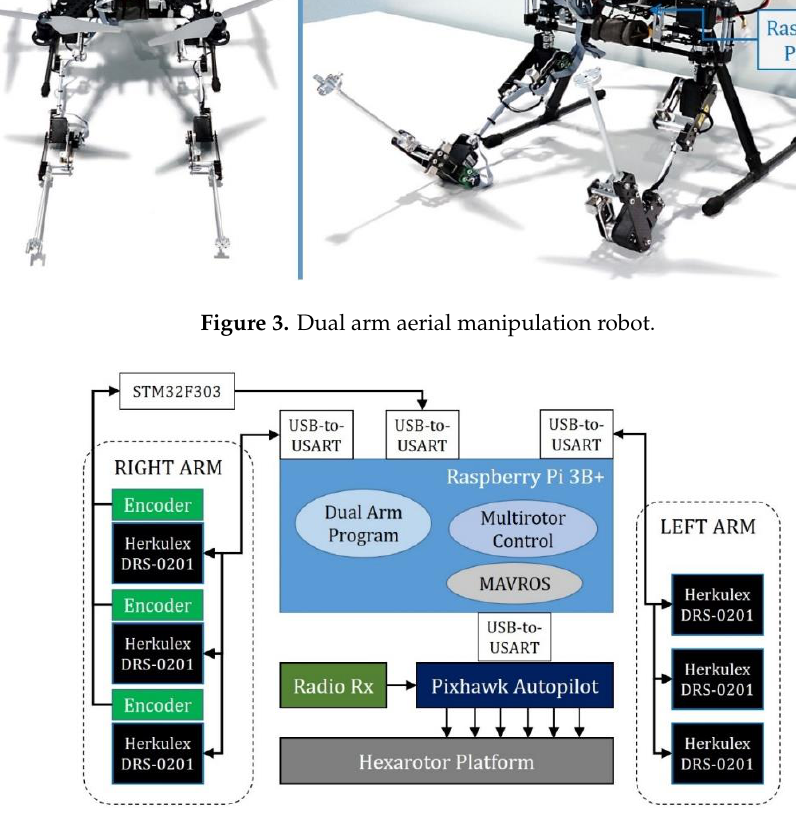
Figure 5: the Earth fixed frame {𝑬} (inertial), the multirotor body frame {𝑩} , and the manipulator